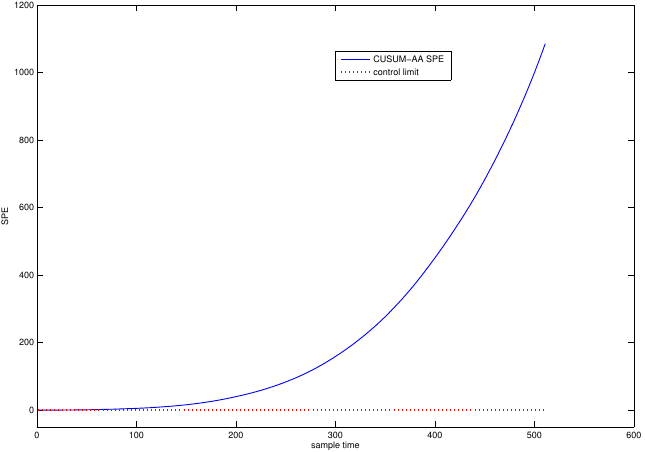
Figure 11. SPE chart for CUMSUM-AA-PCA to historical fault